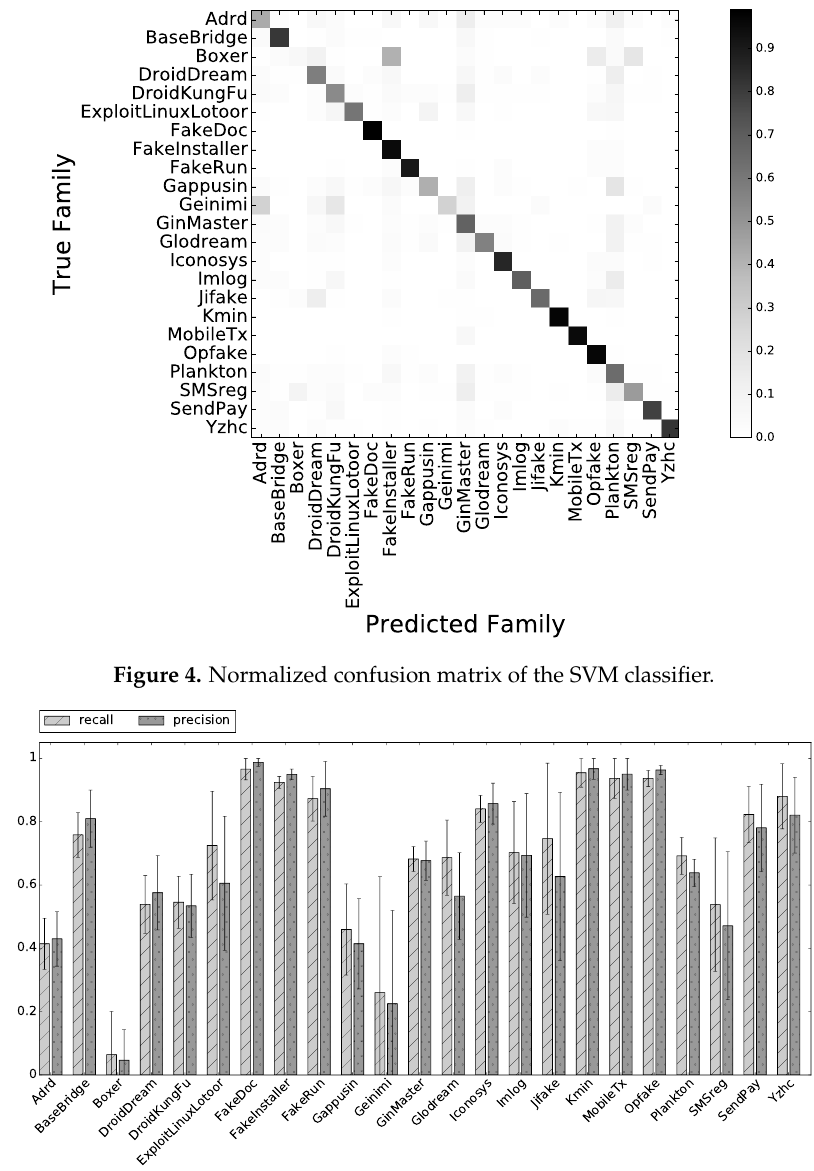
Figure 5. Precision and recall values for all 23